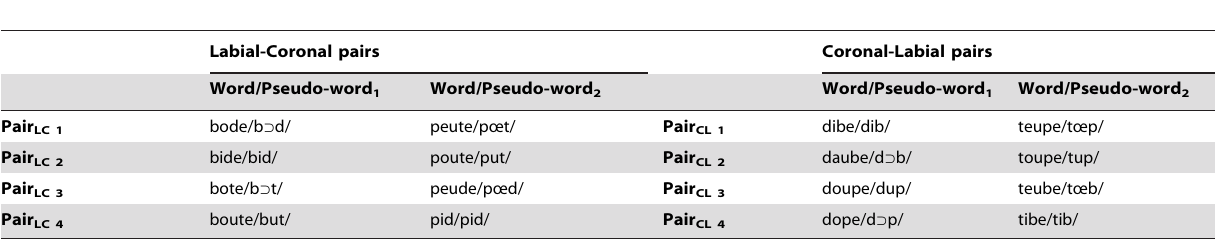
Table 1. Pairs of Labial-Coronal and Coronal-Labial CVC sequences used in Experiments 1 and